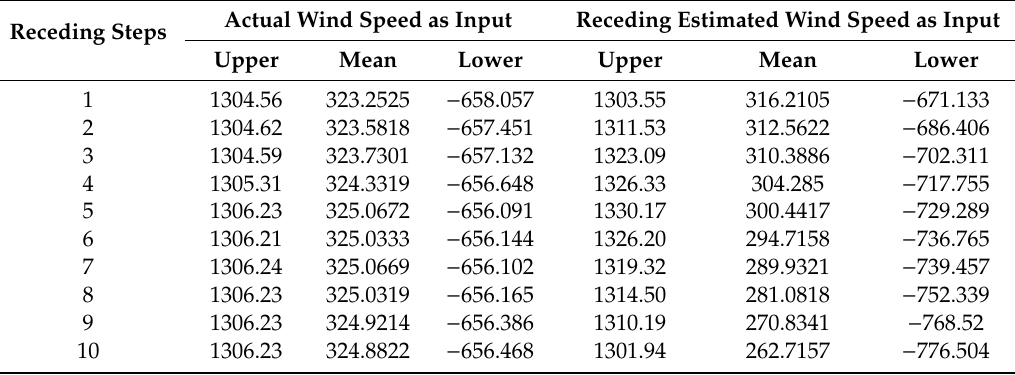
Table 9. Error statistic of ten-step wind power prediction via Gaussian.